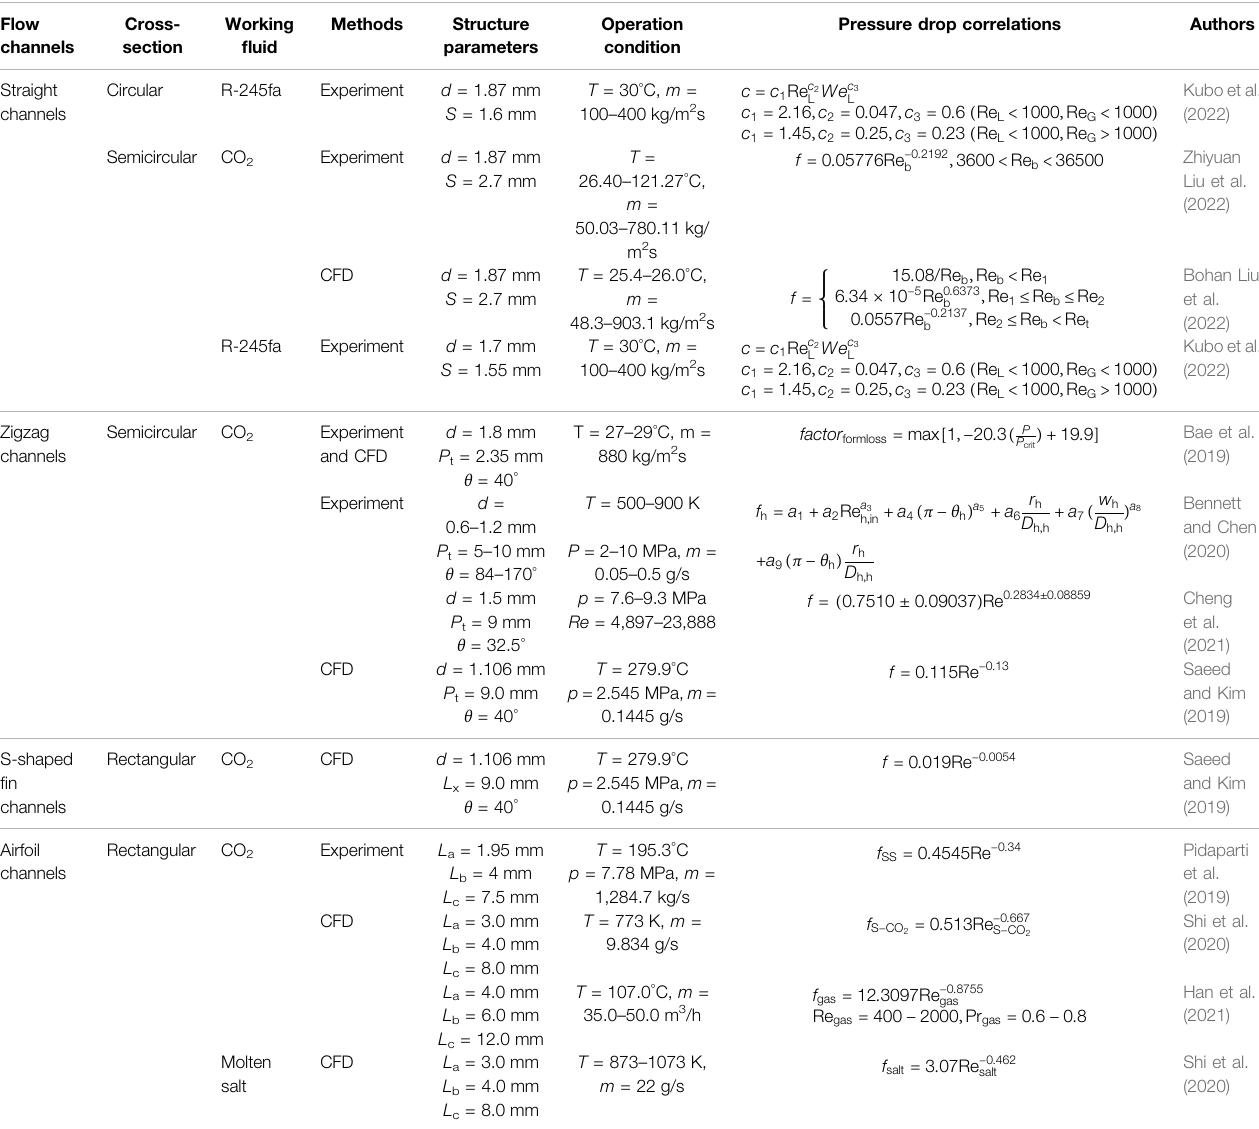
TABLE 3 | Summary of pressure drop correlations for